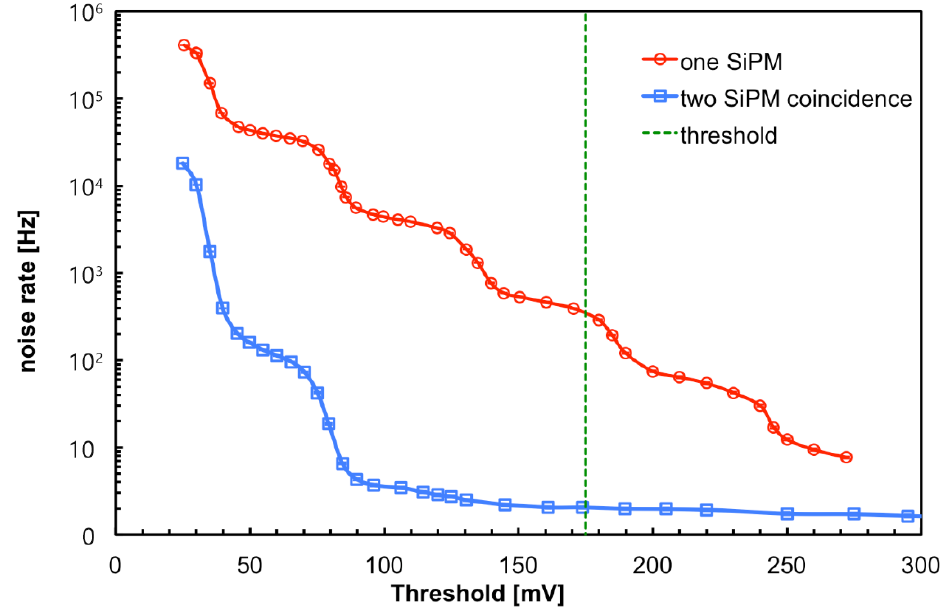
Figure 4. Red line: Typical SiPM staircase plot, obtained by reporting the noise counting rate as a function of the threshold. The final chosen threshold was 175 mV, i.e., 3.5 photons. Blue line: same plot with the SiPMs coincidence signal from a SciFi detector. The constant background above the threshold is physical from cosmic rays and environmental radiation. The error bars are within the symbols.